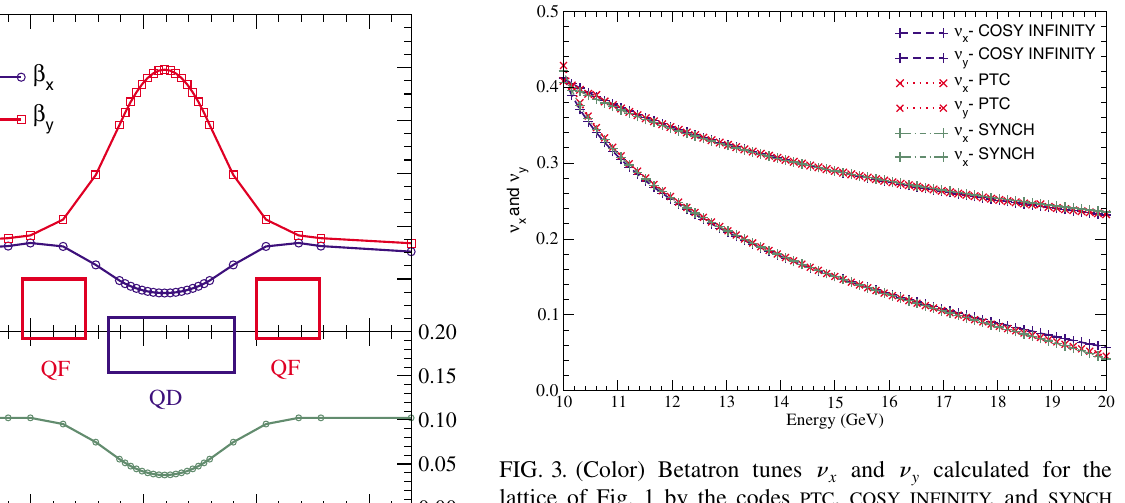
FIG. 3. (Color) Betatron tunes (cid:22) lattice of Fig. 1 by the codes PTC , COSY INFINITY , and SYNCH over the muon acceleration range from 10 to 20 GeV.